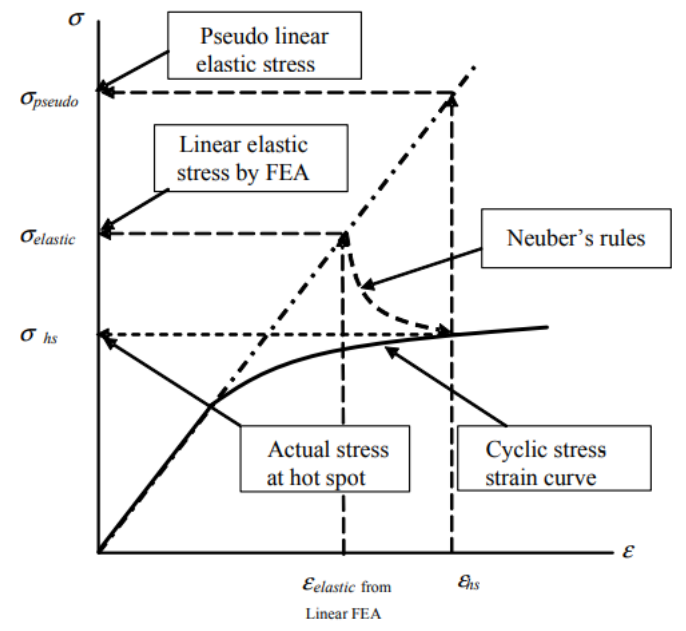
Figure 8. Definition of stresses and strain [7].